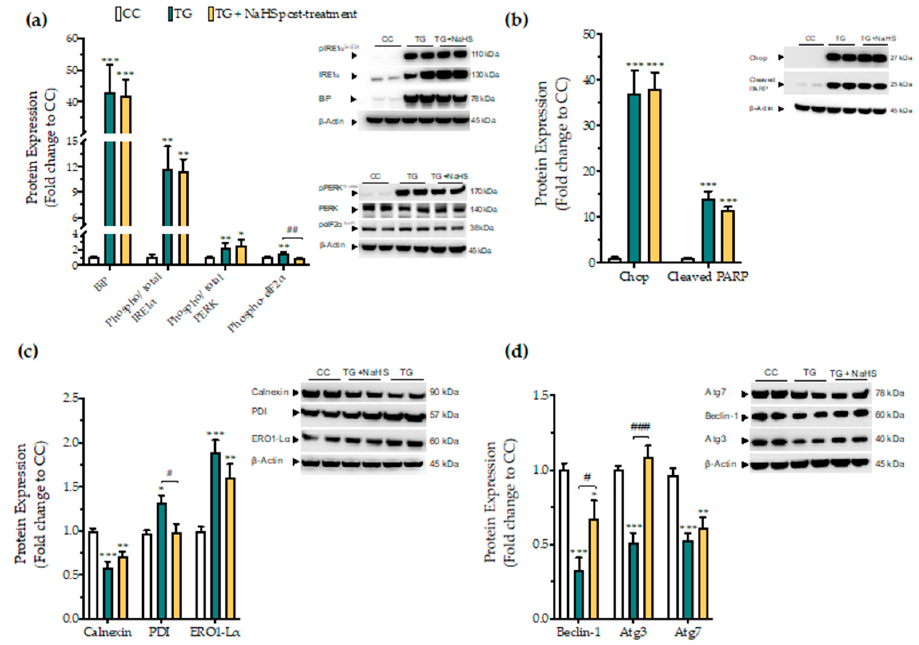
Figure 12. Delayed exogenous supplementation with H 2 S does not ameliorate UPR activation though it partially rescues autophagy impairments. HepG2 cells were serum-starved for 8 h and treated with the vehicle or 100 nM thapsigargin (TG) for 16 h. NaHS treatment initiated 4 h post thapsigargin. Next, cells were harvested and the extracted protein was processed for Western blotting analysis of the expression levels of BiP, activating phosphorylation of IRE1 α at the serine residue 724 (Ser724), the activating phosphorylation of PERK at the threonine residue 980 (Thr980), the inhibitory phosphorylation of eIF2 α at Ser51 ( a ). We additionally quantified the expression levels of the UPR apoptotic mediator Chop and of the cleaved PARP ( b ). Moreover, the expression of the chaperones–calnexin, PDI and ERO1-L α ( c ), and of the autophagy-related proteins (Atg)-beclin-1, Atg3 and Atg7 ( d ) were assessed. Each bar represents mean ± SEM from three independent experiments. Data are expressed as a fold change of the control (vehicle-treated) conditions (CC). * p ≤ 0.05, ** p ≤ 0.01; *** p ≤ 0.001 compared to CC; # p ≤ 0.05, ## p ≤ 0.01, ### p ≤ 0.001 compared to TG-treated cells. For the abbreviations used, please refer to the main text.